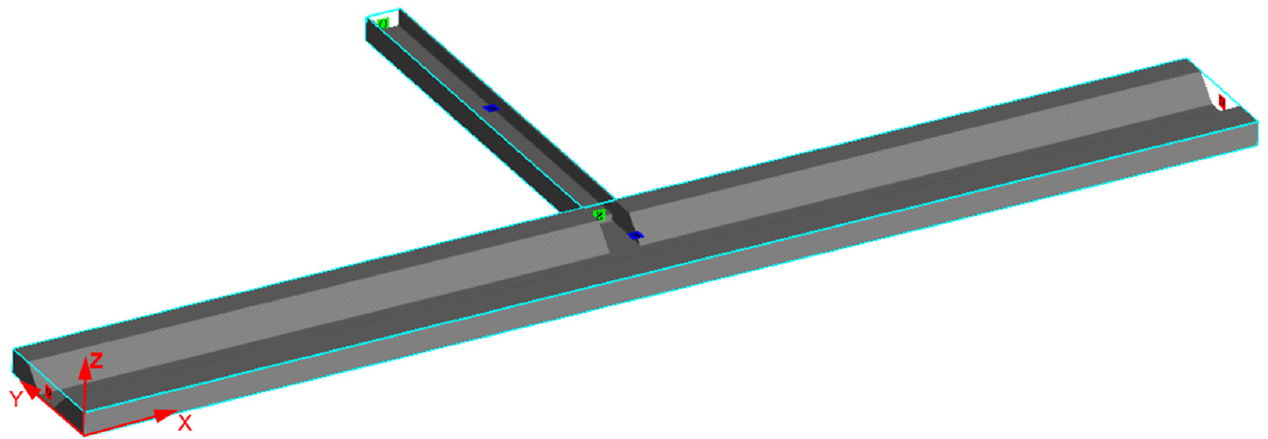
Figure 2. Numerical simulation model and boundary conditions.